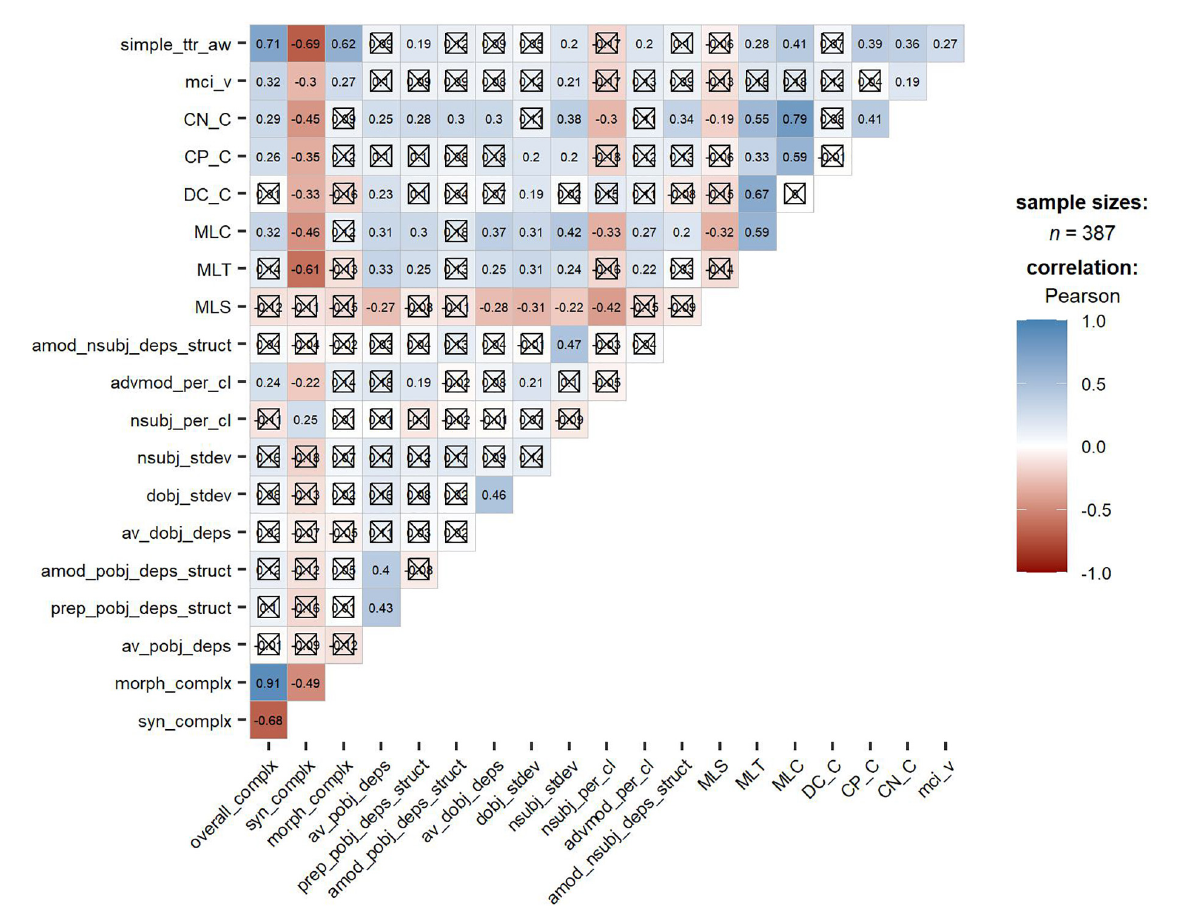
FIGURE5 Correlation among linguistic complexity metrics. The square cross indicates the associated p -values are less than 0.05, so that no significant association is detected between the two metrics; As reported by Wolfe-Quintero et al. (1998), correlations can be marked as strong ( r ≥ 0.65), moderate (0.45 ≤ r < 0.65), and weak (0.25 ≤ r <